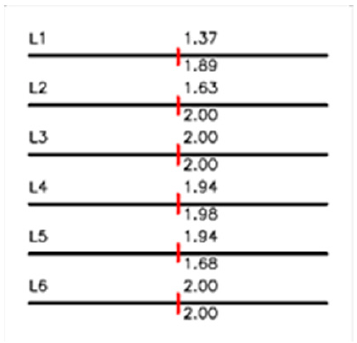
Figure 8. Calculate straightness by comparing the drawn lines with the contour of a nut. Display the farthest distance of the real edge from the fitted line segment on both sides.